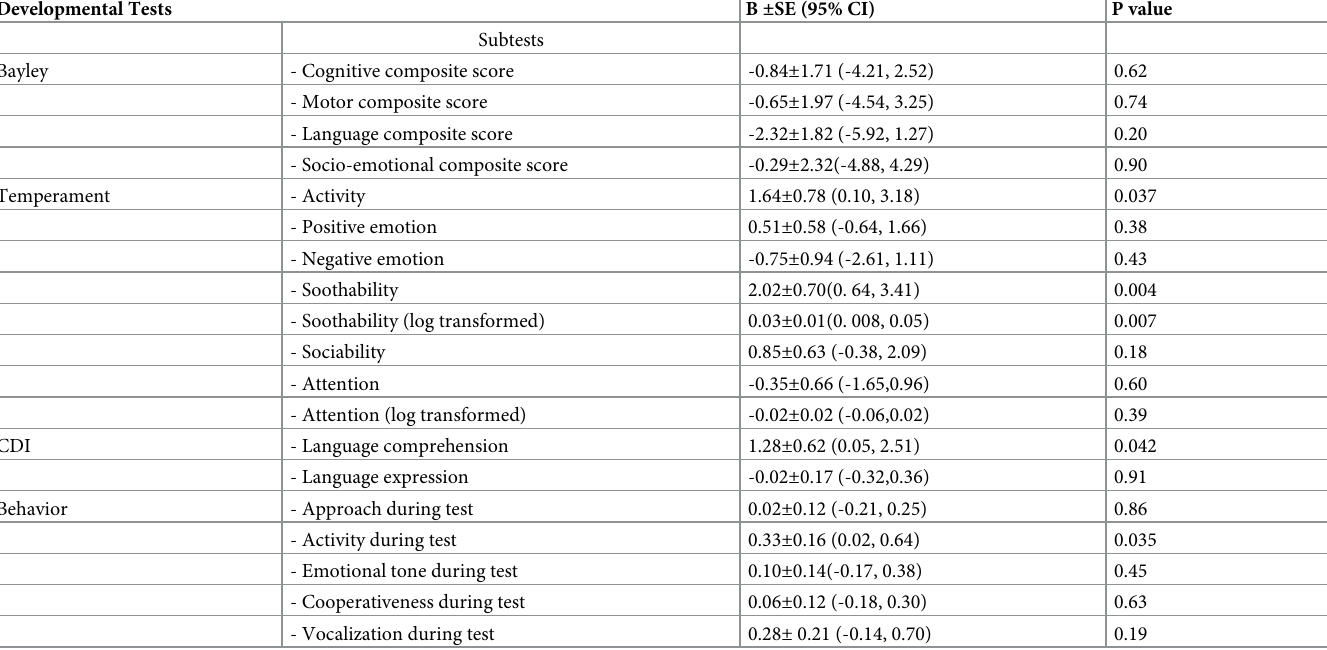
Table 4. Multivariable-adjusted linear regression analysis showing infants’ developmental outcome scores by vitamin D deficient ( < 50 nmol/) and sufficient ( � 50 nmol/) groups. Developmental